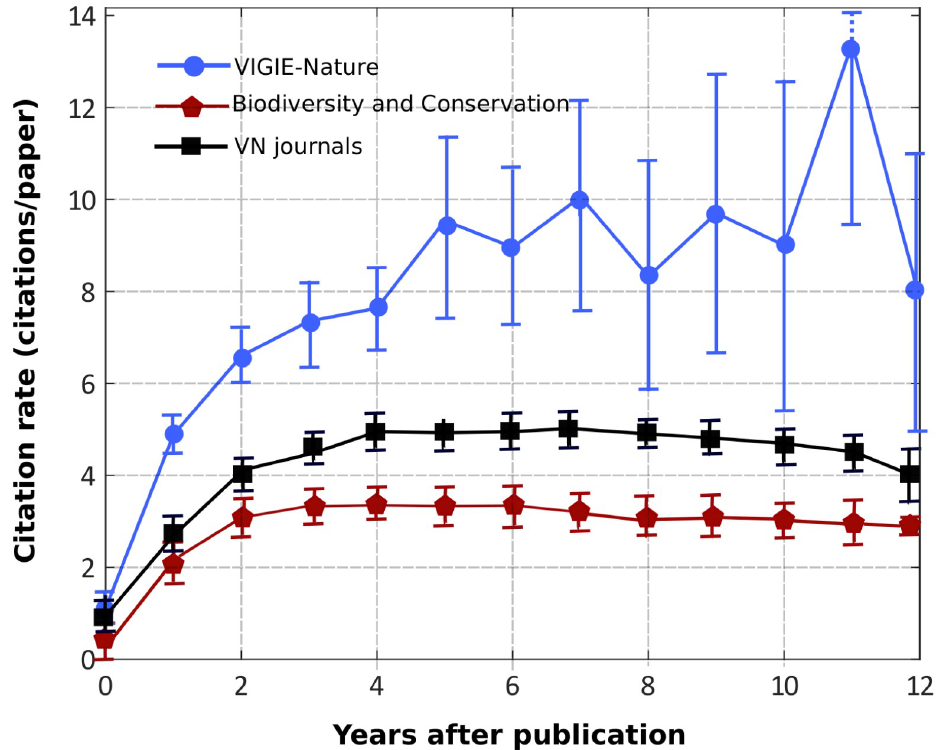
Fig 2. Comparative citation rate history. We plotted the average citation history for Vigie-Nature’s articles (blue, total sample size: 123 articles), for the ‘Biodiversity and Conservation’ articles from WoS (red, sample size: 60847 articles), and for the articles from the Vigie-Nature journals group (black, sample size: 78988 articles).